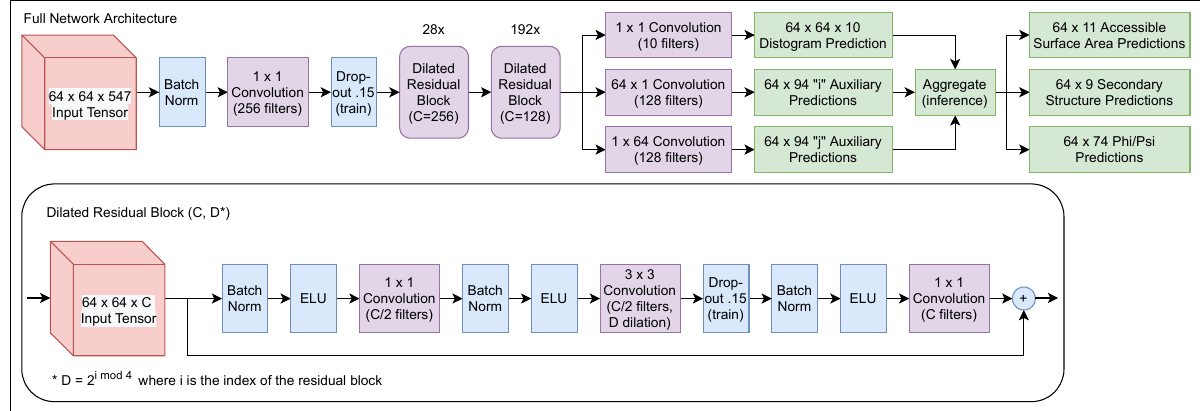
Figure 3. ProSPr network architecture and model architecture.